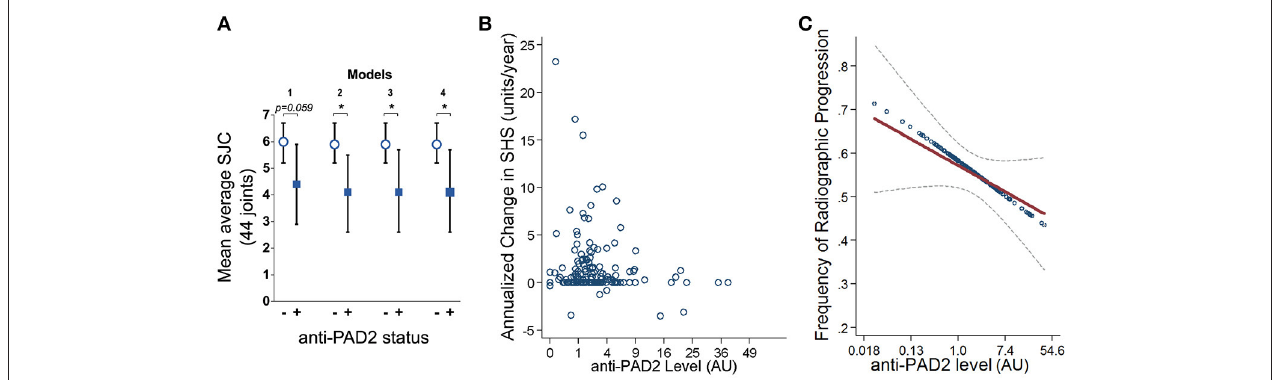
FIGURE 3 | Anti-PAD2 antibodies are inversely associated with progressive joint damage. (A) Mean average SJC over all three visits is shown according to their anti-PAD2 antibody status. The models are adjusted for the co-variates indicated in Figures 2A,B . (B) Yearly change in SHS is plotted versus anti-PAD2 units for each patient. (C) Anti-PAD2 antibody level was plotted against the frequency of radiographic progression in unadjusted (blue circles) and adjusted (red line) models, and the least squares estimate of the association from multivariable linear regression with its associated 95% confidence interval (gray dotted line) is shown. A p < 0.05 was considered significant (*). AU, arbitrary units.